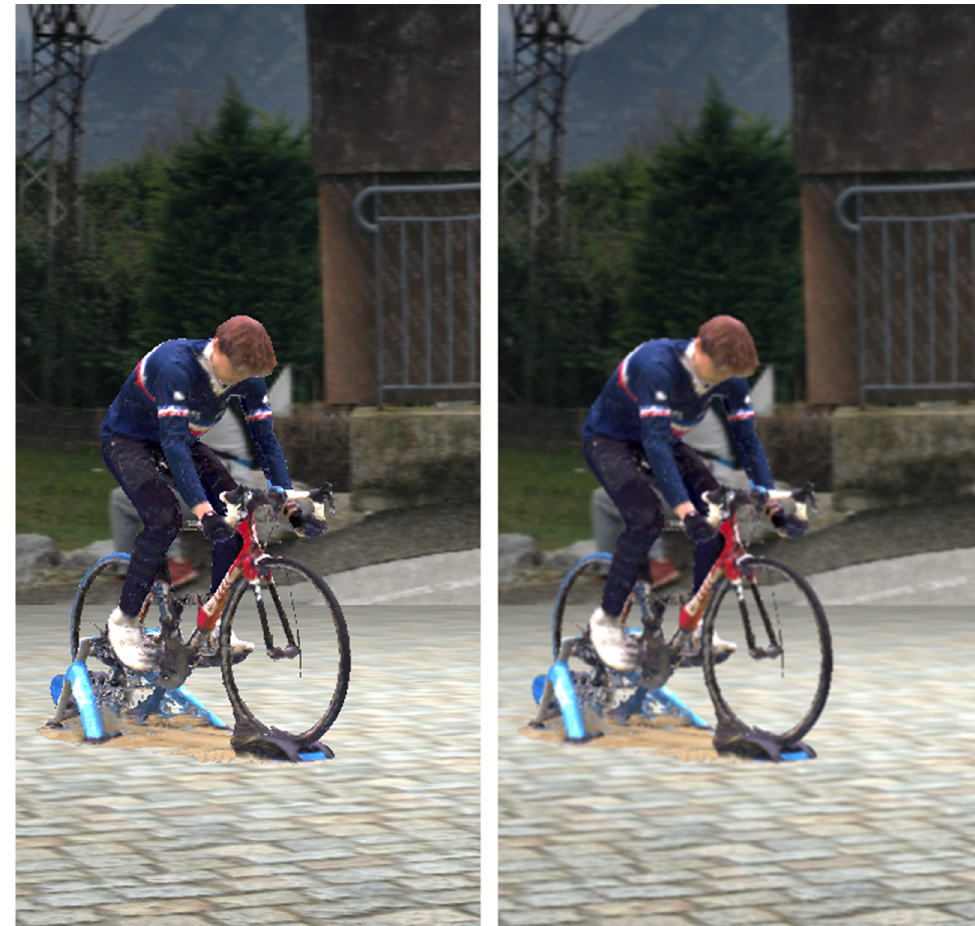
Figure 4. To smooth out sharp edges due to compositing, we applied a 3 × 3 pixel Gaussian blur to the videos filmed from our virtual scene.